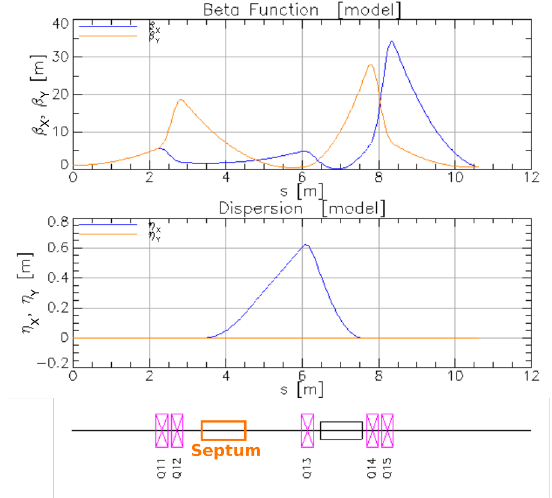
Figure 4. Double-bend achromat systems as used in the first and third segment according to figure 3. This system will be used in three di ff erent orientations. One for bending up into the vertical plane and another one for bending back into the horizontal plane in segment one. Another one for bending down into the vertical plane and towards the target station in segment three.